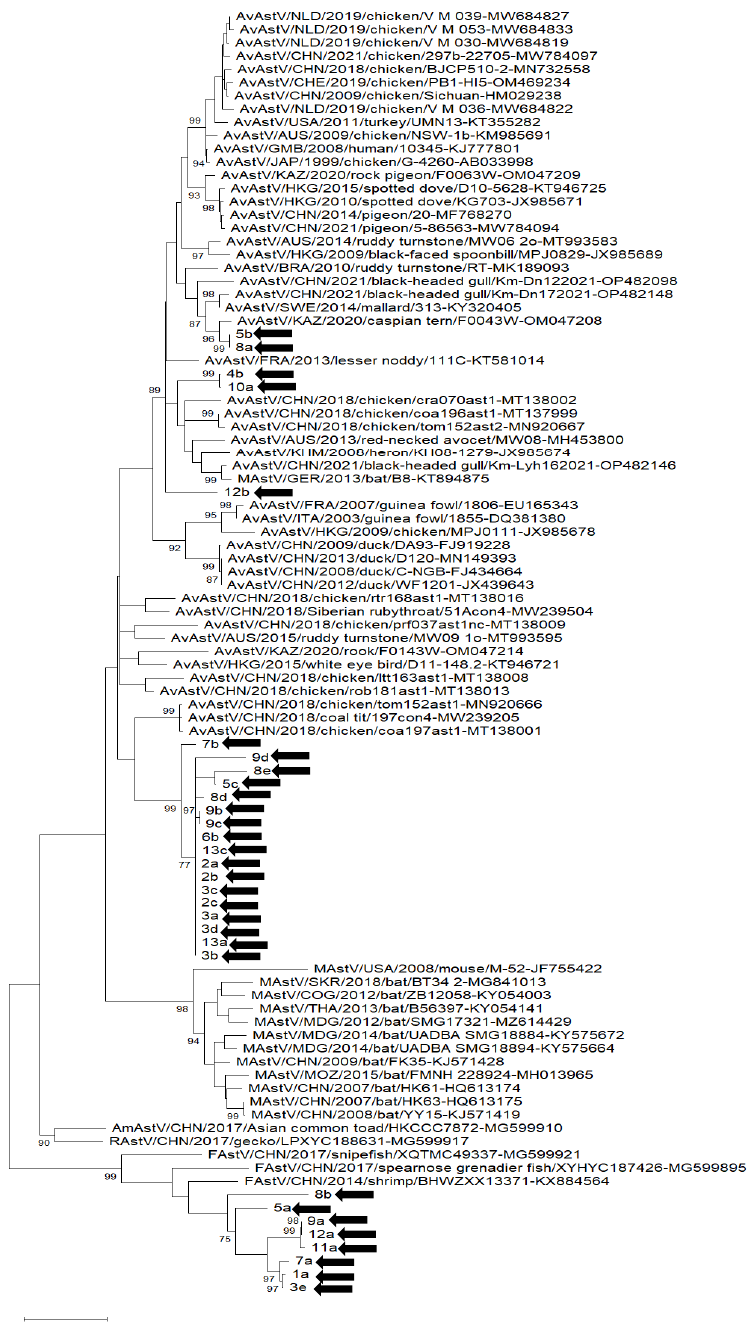
Figure 3. Unrooted phylogenetic tree based on partial ORF1b (201nt) of Astrovirus (AstV) strains identified in this study and reference strains recovered in the GenBank database. AstV strains 4a, 6a, 6c, 7c, 7d, 8c and 13b were excluded from the phylogenetic tree due to the limited size of the sequences obtained. The Maximum Likelihood method and Tamura-Nei model (four parameters) with a gamma distribution and invariable sites were used for the phylogeny. One thousand bootstrap replicates were used to estimate the robustness of the individual nodes on the phylogenetic tree. Bootstrap values higher than 75% are displayed. Black arrows mark strains detected in this study. Numbers of nucleotide substitutions are indicated by the scale bar. MastV = AstV identified in mammalian host; AAstV = AstV identified in avian host; RastV = AstV identified in reptilian host, AmAstV identified in amphibian host; FastV = AstV identified in fish and marine